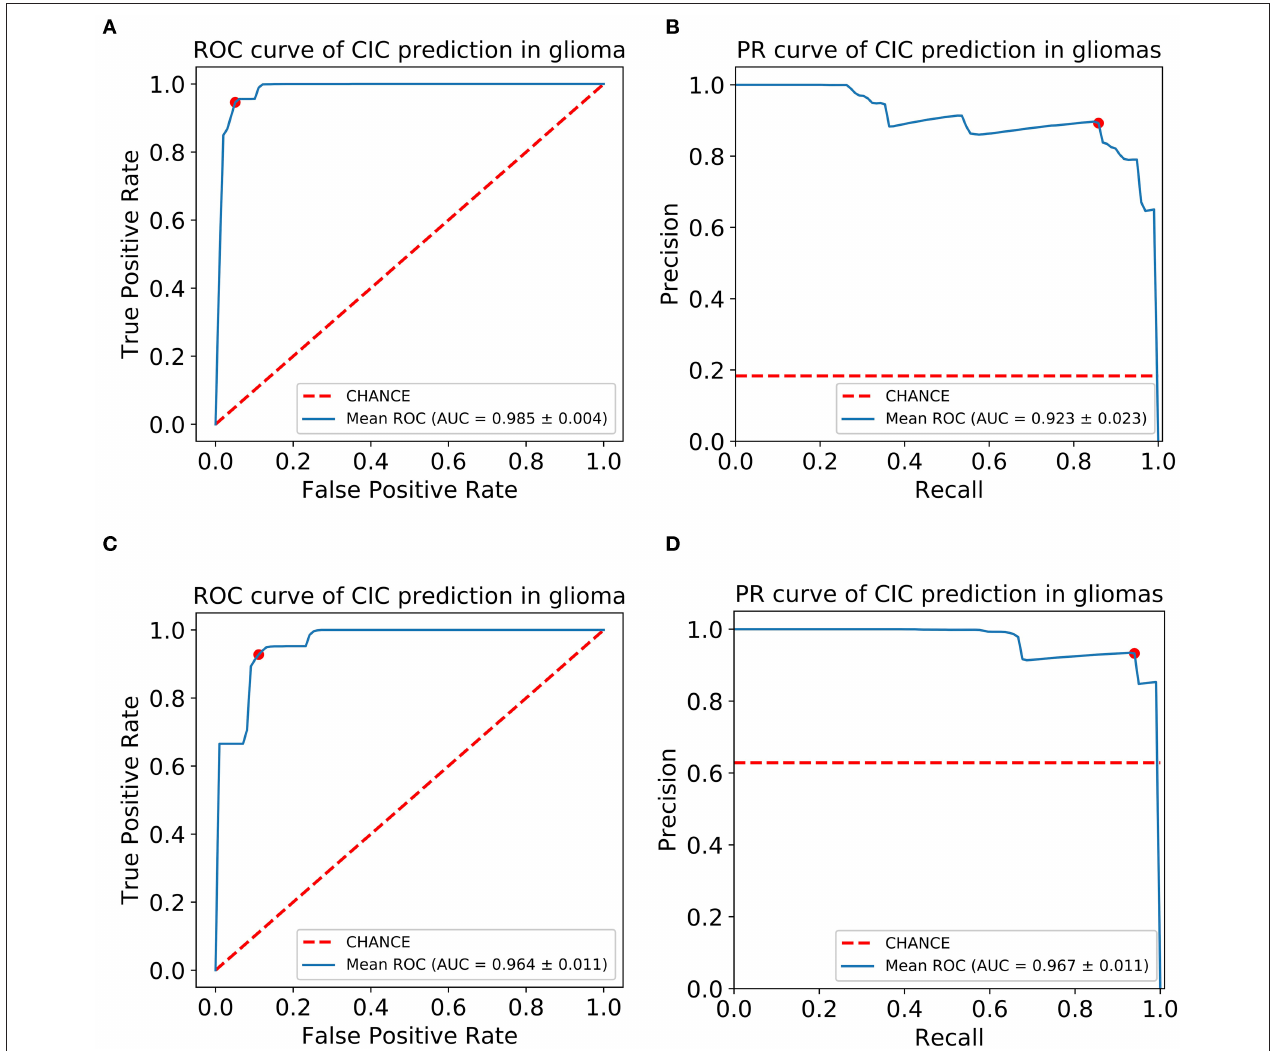
FIGURE 7 | CIC mutation has a potential diagnosis value in glioma. (A) Receiver operating characteristic (ROC) curve of glioma CIC mutation prediction model. (B) Precision-recall (PR) curve of glioma CIC mutation prediction model. (C) Receiver operating characteristic (ROC) curve of oligodendroglioma CIC mutation prediction model. (D) Precision-recall (PR) curve of oligodendroglioma CIC mutation prediction model. The optimal cutoff value in ROC curve is the point (red dot) that has the smallest distance to (0,1), or (1,1) in PR curve.